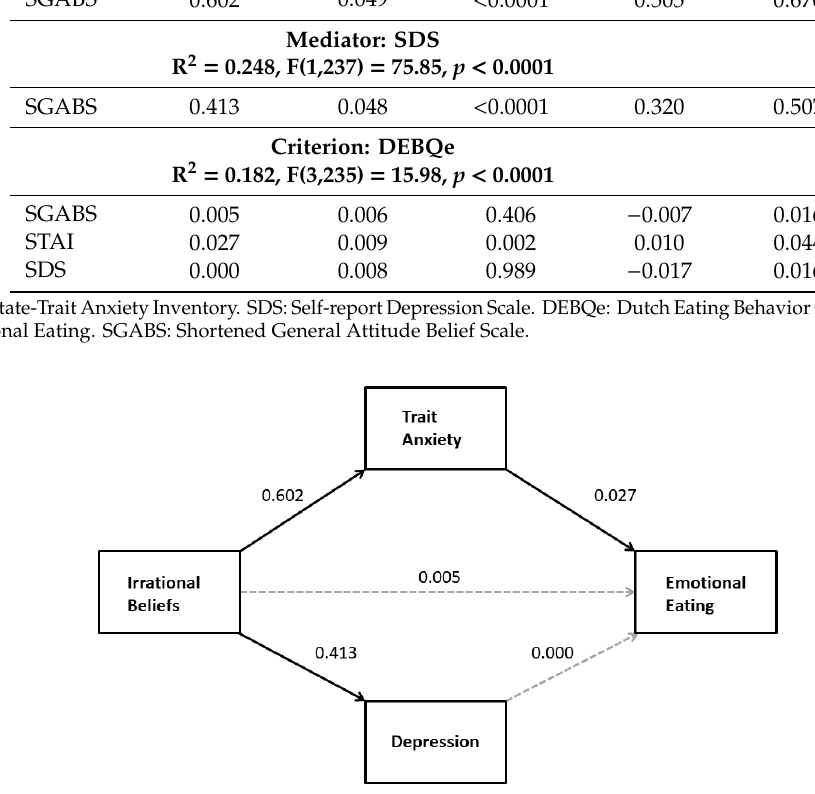
Figure 3. The relationship between irrational beliefs and emotional eating is mediated by trait anxiety but not depression. Solid arrows indicate statistically significant regression coefficients.